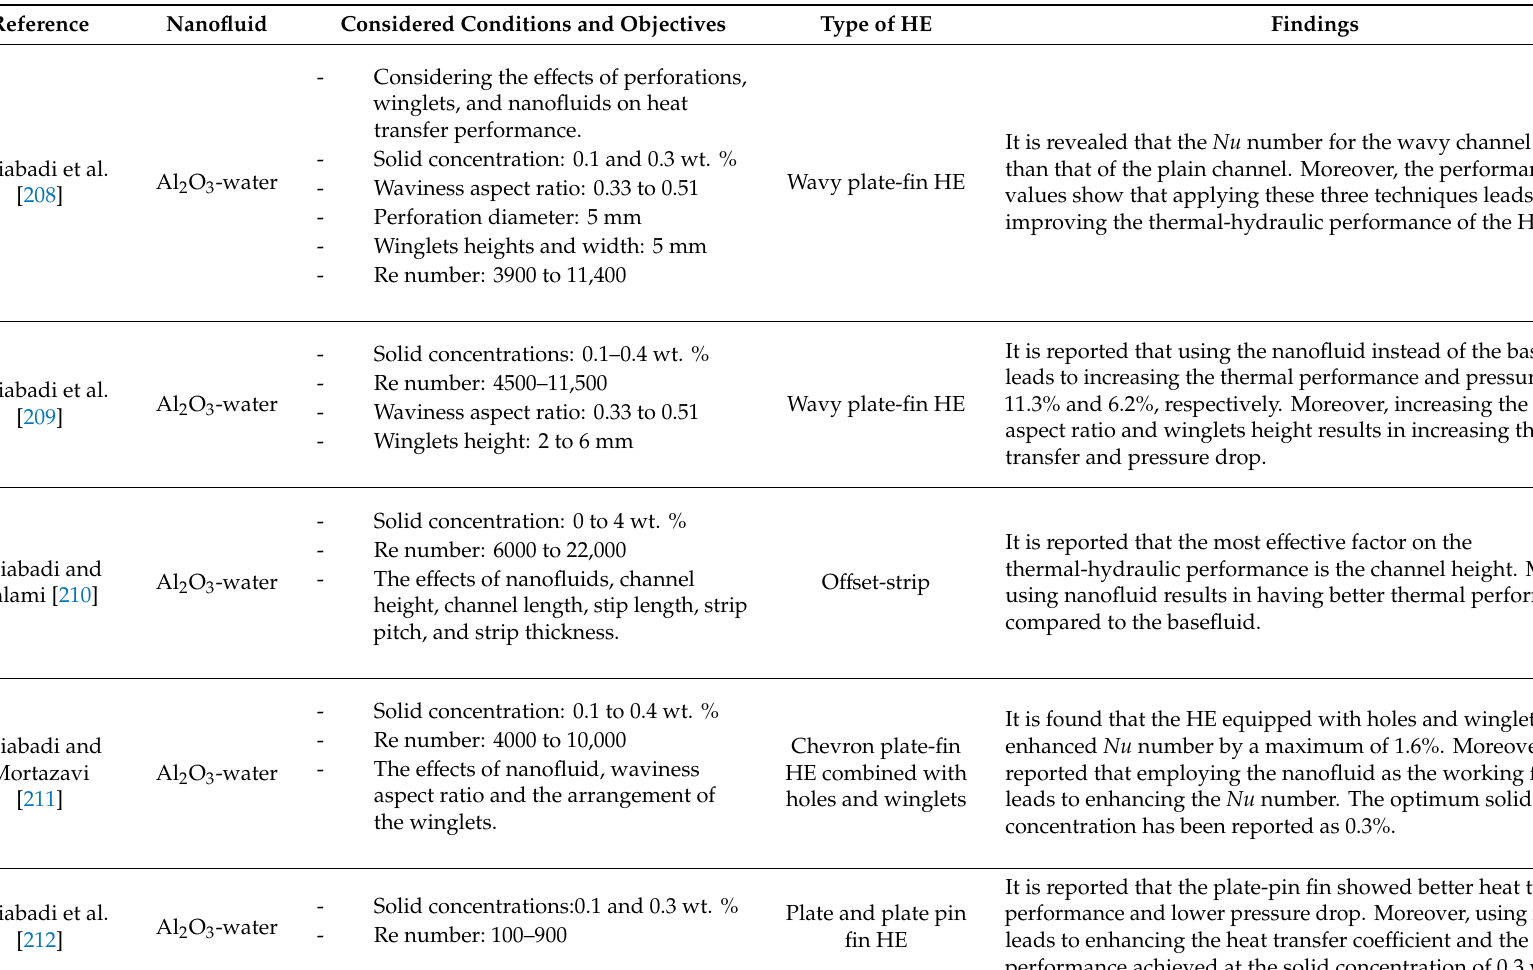
Table 3. A summary of the available literature on the e ff ects of nanofluids, vortex-generators, winglets, and perforations on the thermal-hydraulic performance of plate-fin